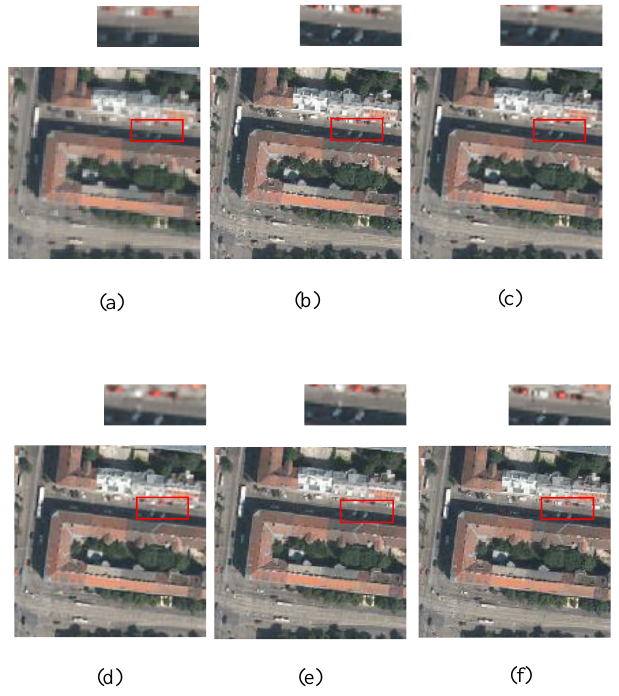
Figure 4. Comparison of reconstruction results using the Inria aerial dataset: ( a ) bicubic; ( b ) ESPCN;